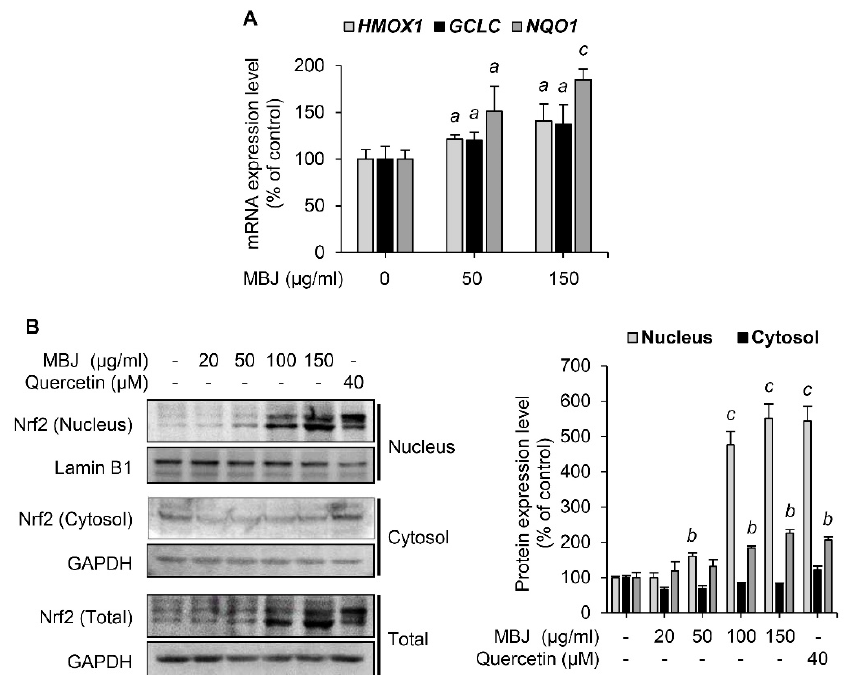
Figure 3. Effects of MBJ on the Nrf2 signaling pathways. ( A ) The relative mRNA expression levels of HMOX1, GCLC , and NQO1 in RAW 264.7 macrophages were analyzed via RT-qPCR and presented as a bar graph. The data are shown as the mean ± SEM; a p < 0.05 and c p < 0.001 vs. the MBJ- untreated group. ( B ) Nrf2 protein levels in the nucleus were analyzed after subcellular fractionation of MBJ-treated RAW 264.7 macrophage cells. Quercetin was used as a positive control. All protein levels were quantified using the LabWorks software and were normalized to the corresponding Lamin B1 or GAPDH levels. The data represent the mean ± SEM; b p < 0.01 and c p < 0.001 vs. the non-treated groups.